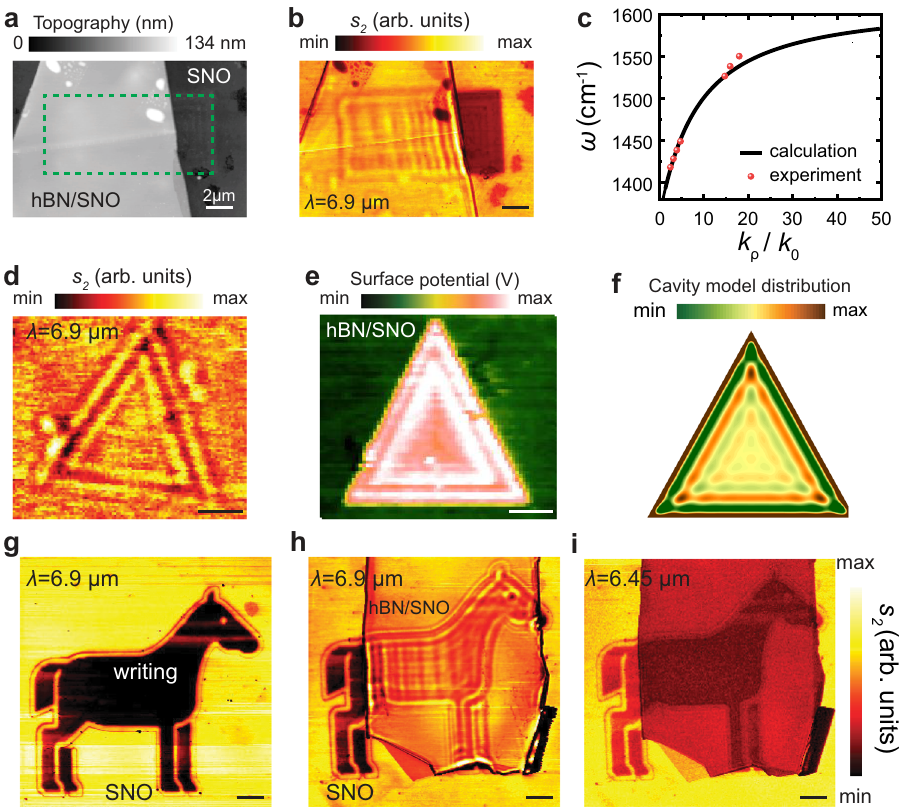
Fig. 4 | Tunable polaritonics withhBN/SNO architectures.a Topographicimage ofpristineSNO,alithographypatternisperformedbyapplying10Vpotentialatthe c-AFMtip,anda fl akeof60nmhBN(~99%boron-10enriched)istransferredontop, green dashed lines show the charge written region on SNO. b IR s-SNOM second harmonic near- fi eld amplitude s 2 image. c Measurement of the dispersion relation of HPhPs in 60nm thick hBN on SNO. d Second-harmonic near- fi eld amplitude s 2 image of a 60nm hBN fl ake transferred on a triangular cavity lithographically